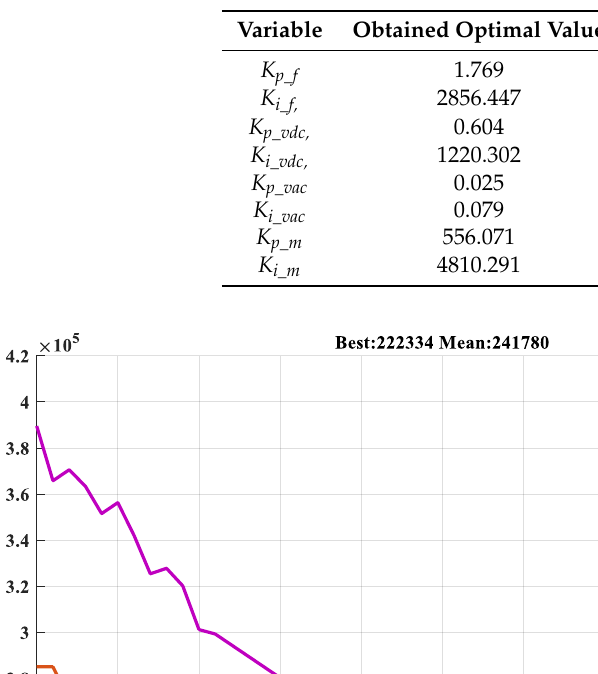
Table 2. The optimal control parameters.